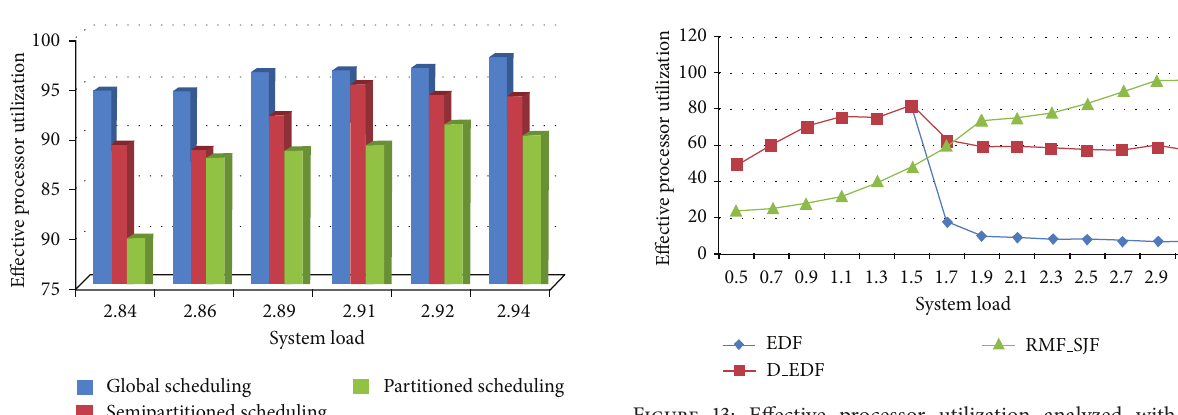
Figure 13: Effective processor utilization analyzed with EDF, D EDF, and